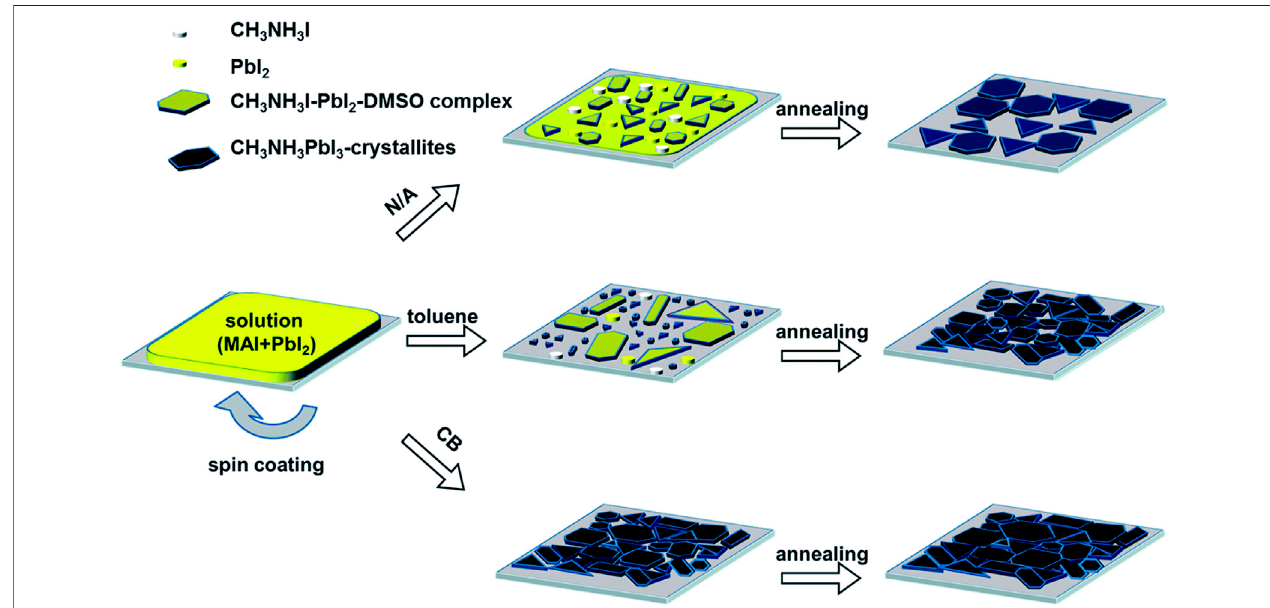
FIGURE 6 | Schematic illustration of the different morphological development with different solvent washing processes. Reproduced with permission (Jun et al., 2014). Copyright 2014, The Royal Society of Chemistry.